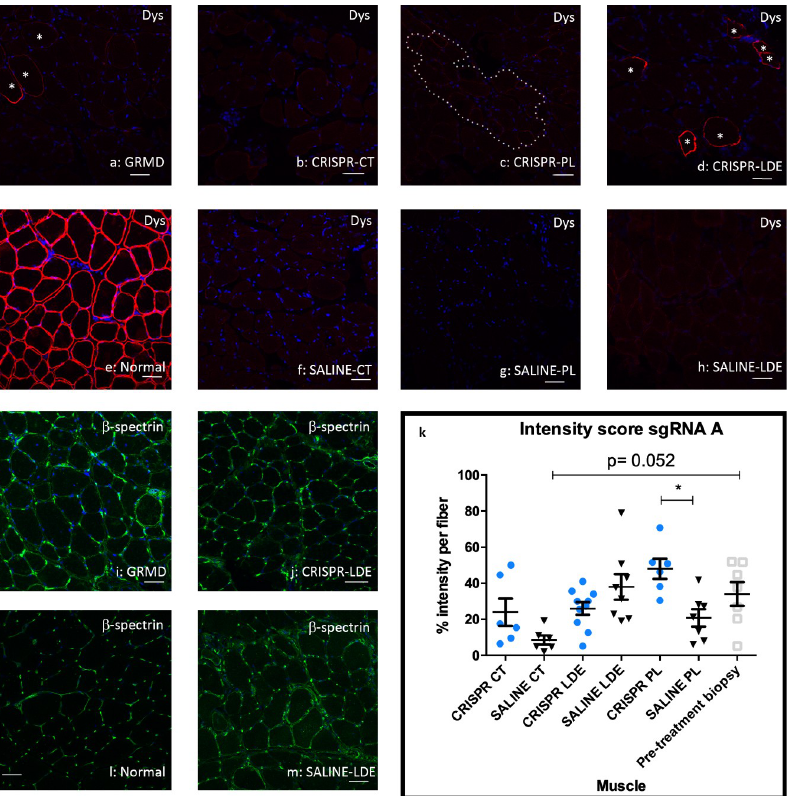
Fig 6. Dystrophin expression was minimally restored in HDR-CRISPR-Tx muscle from sgRNA A. Dystrophin co- stained with C and N-terminus antibodies with Alexa 647 (red), β -spectrin membrane control (green) and DAPI denotes the nuclei (blue). Asterisks denote cells with a value of 2 in intensity score for dystrophin signal in the GRMD non-Tx and Tx samples. Dotted line denotes cells with a value of 1 in intensity score. Scale bar = 50 μ m. (a) Pre- treatment biopsy sample for Miercoles. (b) HDR-CRISPR injected cranial tibial (CT) Miercoles. (c) HDR-CRISPR injected peroneus longus (PL) Miercoles. (d) HDR-CRISPR injected long digital extensor (LDE) Miercoles. (e) Normal dog muscle. (f) SALINE injected CT Miercoles. (g) SALINE injected PL Miercoles. (h) SALINE injected LDE Miercoles. (i) Pre-treatment biopsy sample for Miercoles. (j) HDR-CRISPR injected LDE Miercoles. (k) Dystrophin intensity quantification for Miercoles and Clove via One-way ANOVA multiple comparisons test, blue circle indicates CRISPR-Tx limb, black triangle indicates Saline-Tx limb, gray square indicates pre-treatment biopsied sample; � p < 0.05. (l) Normal dog muscle (m) SALINE injected LDE Miercoles. Dys = dystrophin; p = p.